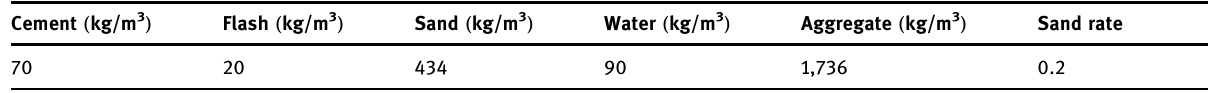
Table 6: Mix proportions used in the uniaxial compression test Cement ( kg/m 3